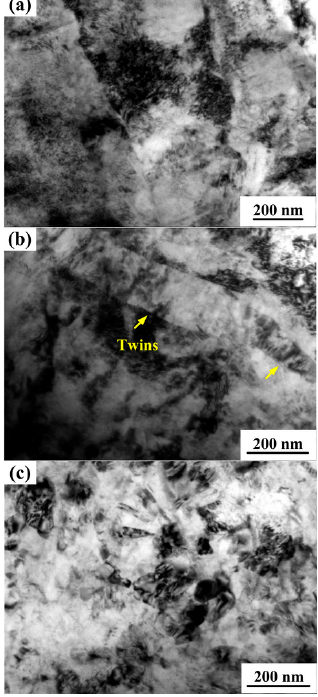
Figure 2. Transmission electron microscopy (TEM) bright field images at ( a ) about 120 μ m below the top surface, ( b ) about 60 μ m below the top surface, and ( c ) the top surface.